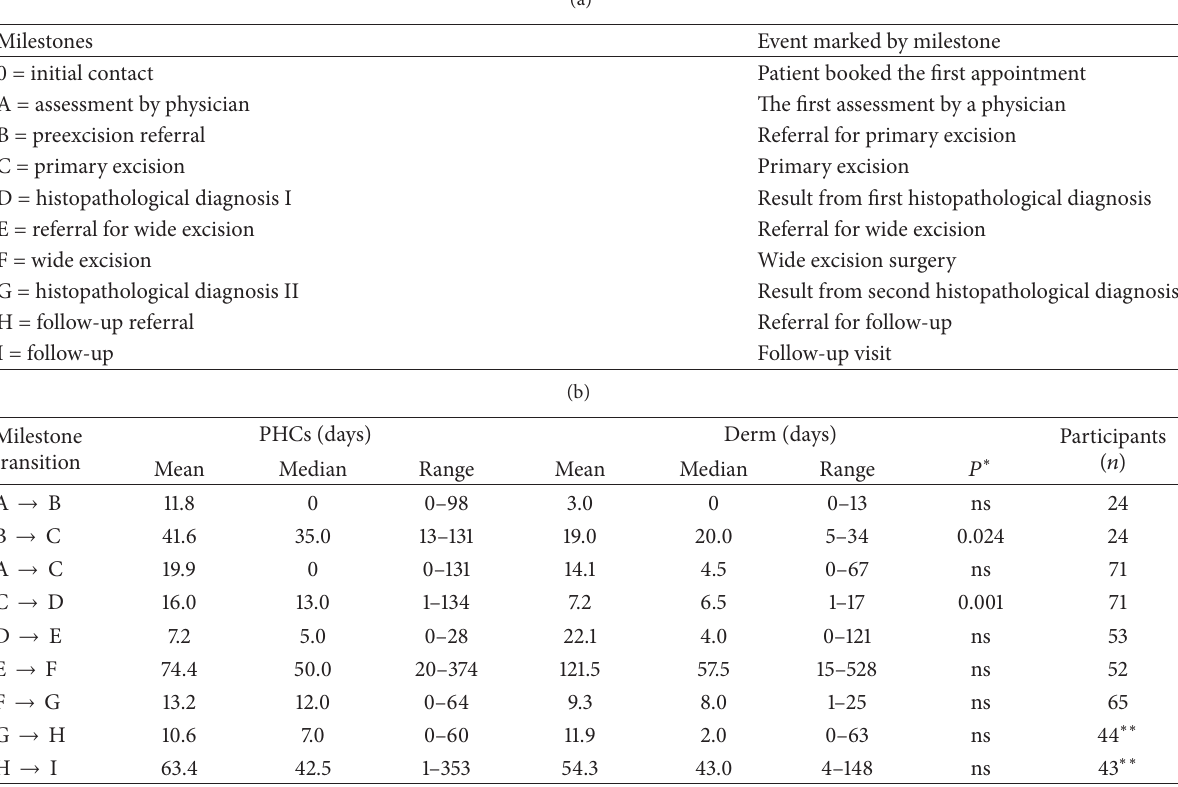
Table 2: (a) Definition of milestones. (b) Mean, median, and range (in days) between milestones in the clinical pathway of melanoma patients seeking care at either PHCs or Derm